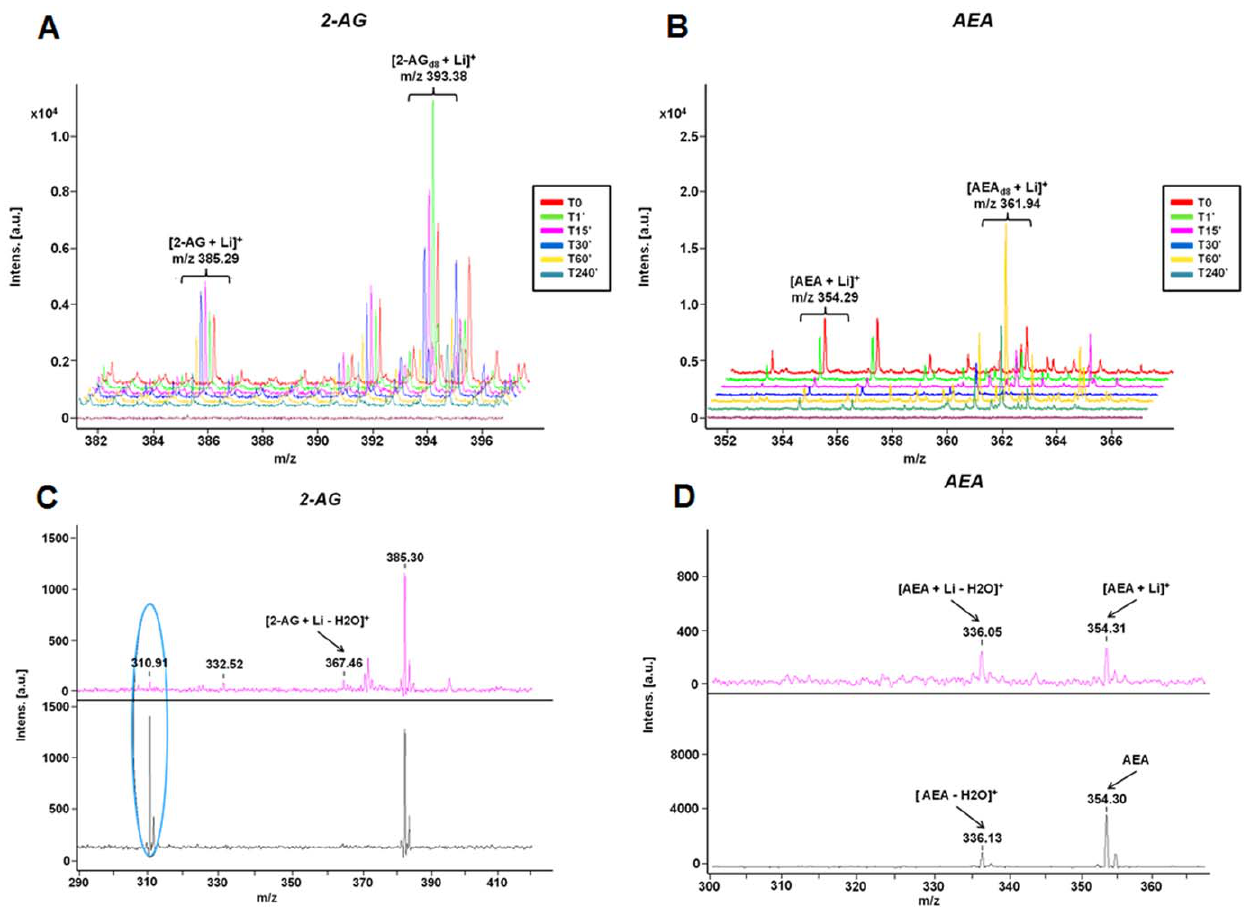
Figure 7. Levels of cannabinoids change as a function of time after injury. Time course MALDI-TOF measurement of cannabinoids in injured nerve cords from time 0 to time 240 minutes. A . Levels of 2-AG and 2-AG deuterated (D 2 O) with lithium chloride addition after the nerve cord lesions. B . Levels of AEA and AEA deuterated (D 2 0) with lithium chloride addition after nerve cord crush. C . MALDI-MS spectra of standards of 2-AG and 2-AG with lithium chloride addition. D . MALDI-MS spectra of standards of AEA and AEA with lithium chloride addition.